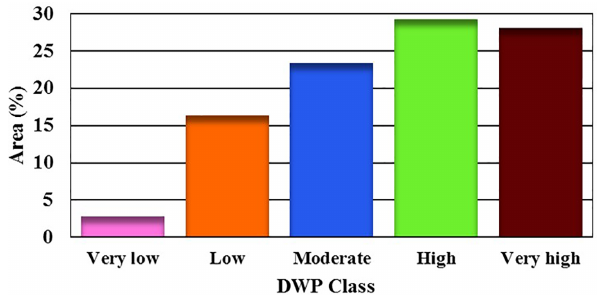
Figure 6. Area percentages of the different DWP classes in the West Bank.